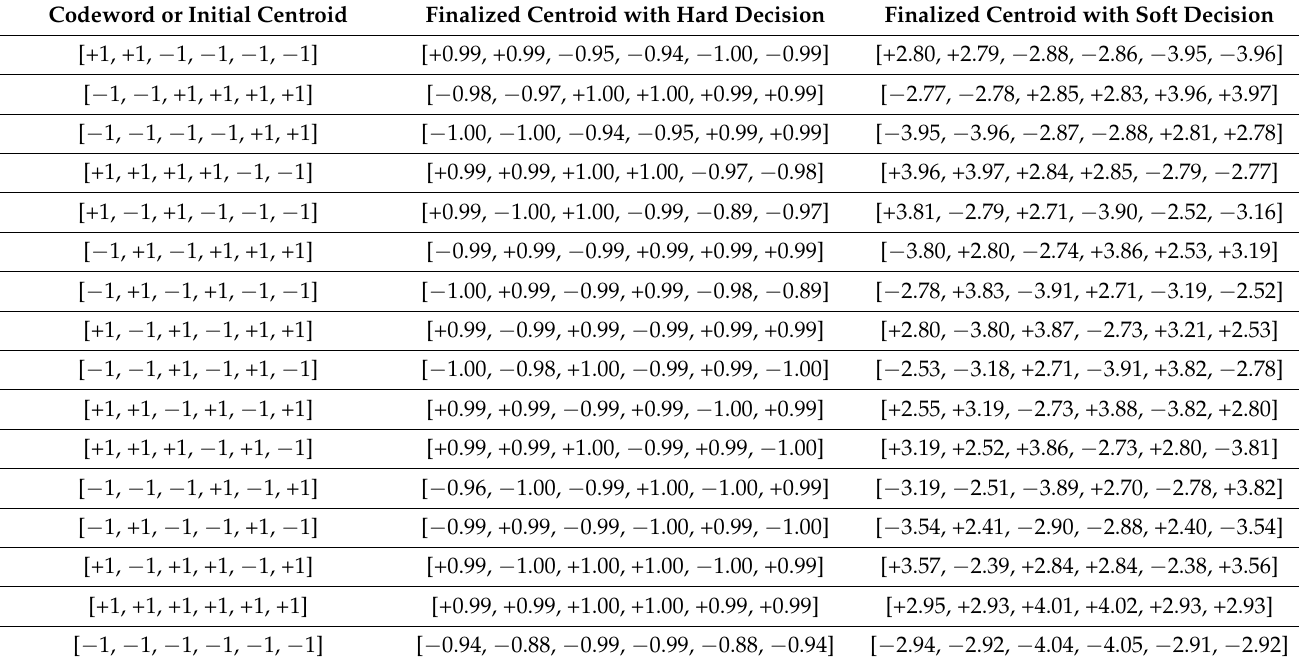
Table 3. Centroids of K-means decoder according to hard and soft decision at SNR = 14 dB.